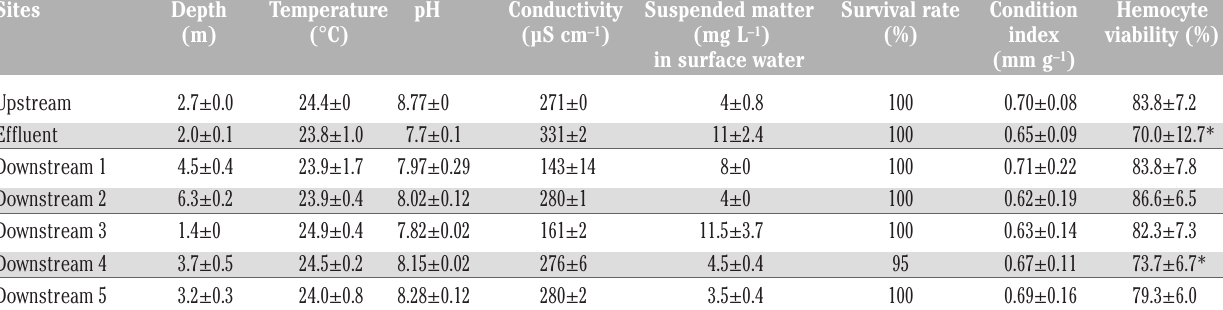
Table 1. Water characteristics at the different sites and summary of biological parameters.